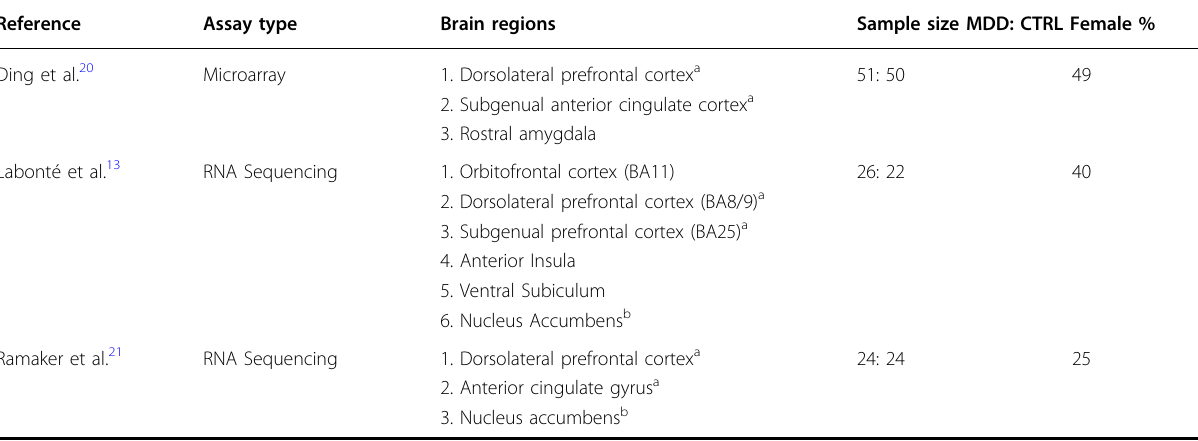
Table 1 Characteristics of the MDD transcriptomic